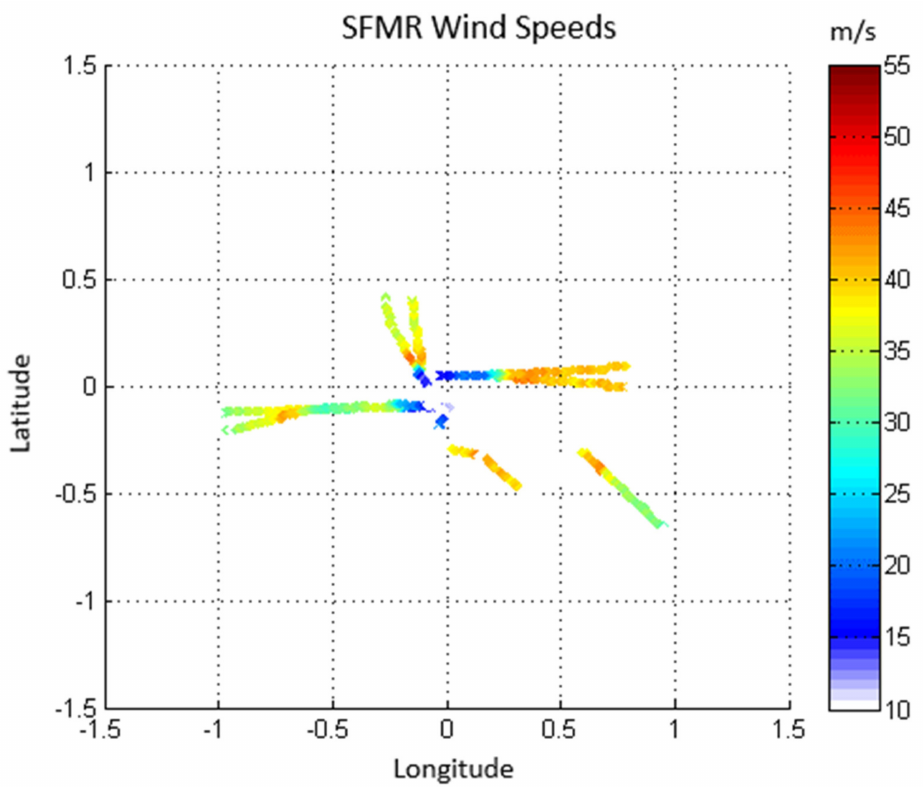
Figure 2. SFMR WS measurement over Hurricane Gonzalo on 17 October in storm-relative